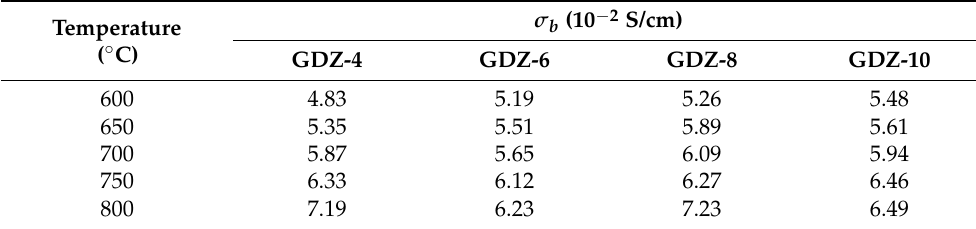
Table 3. Conductivity values at different ambient temperatures of GDZ pellets in the air atmosphere.